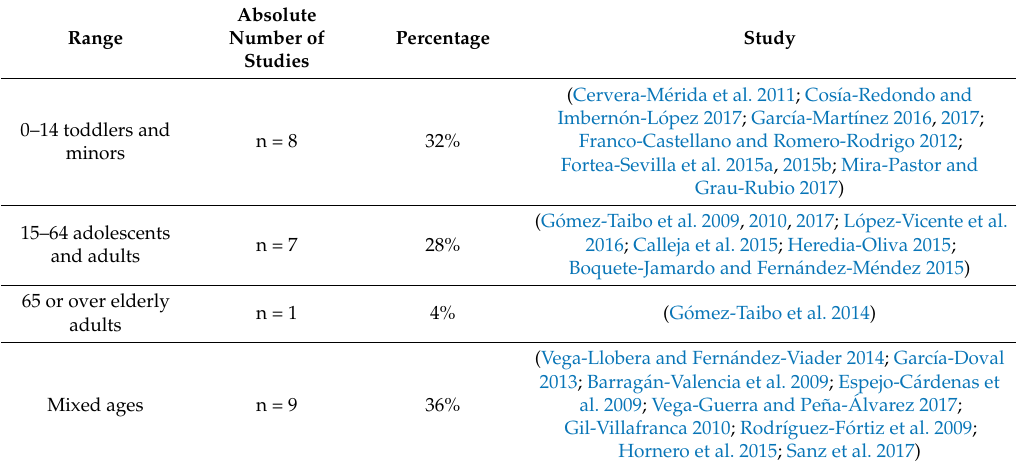
Table 2. Distribution of the studies according to the age of the